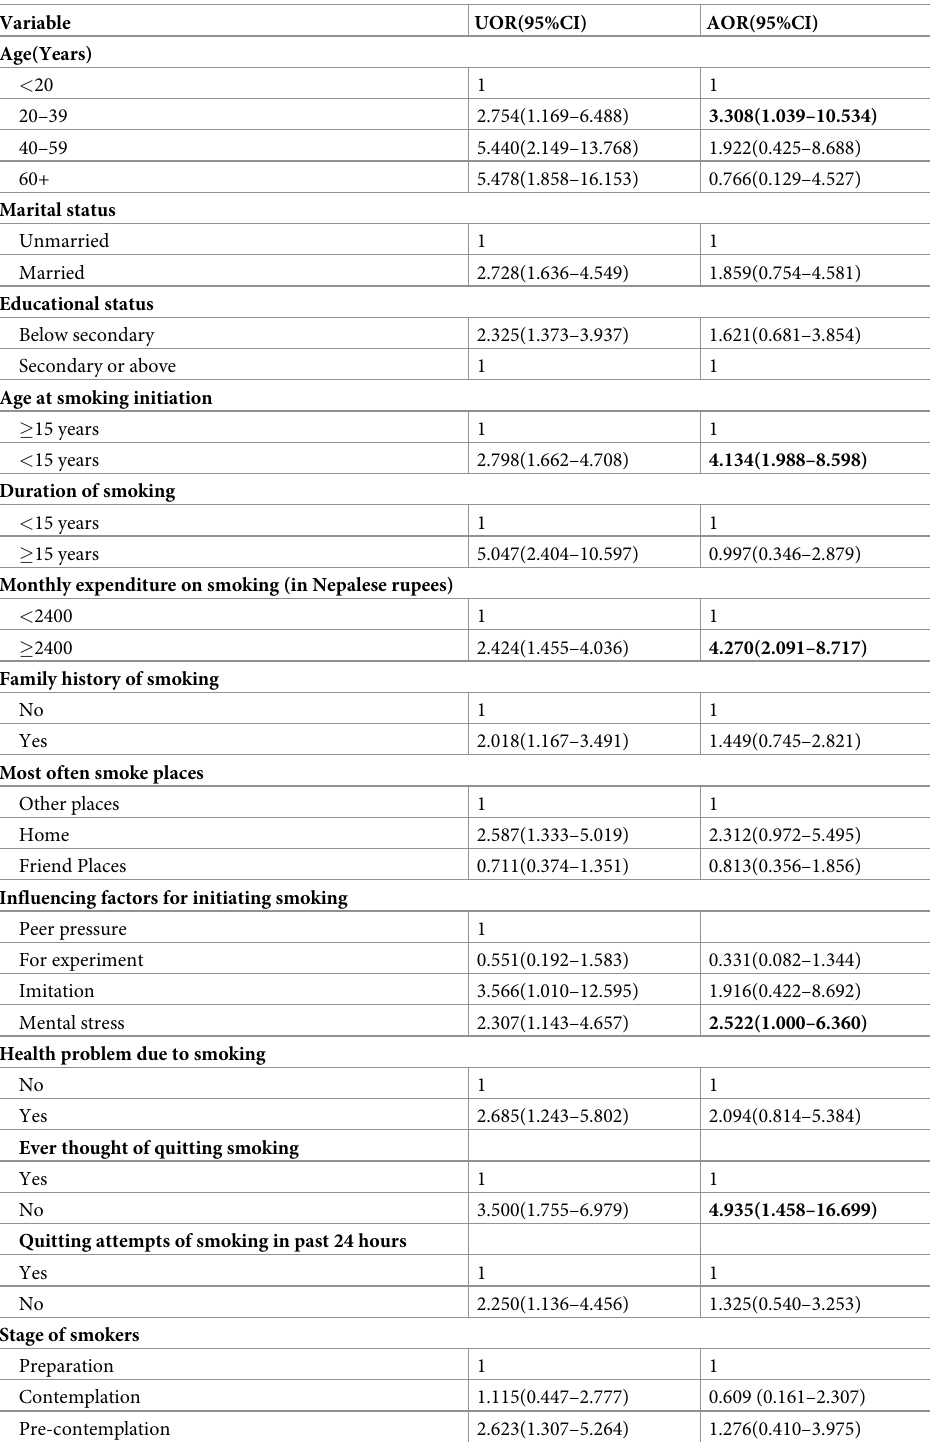
Table 5. Bivariate and multivariate logistic regression analysis between nicotine dependence and selected